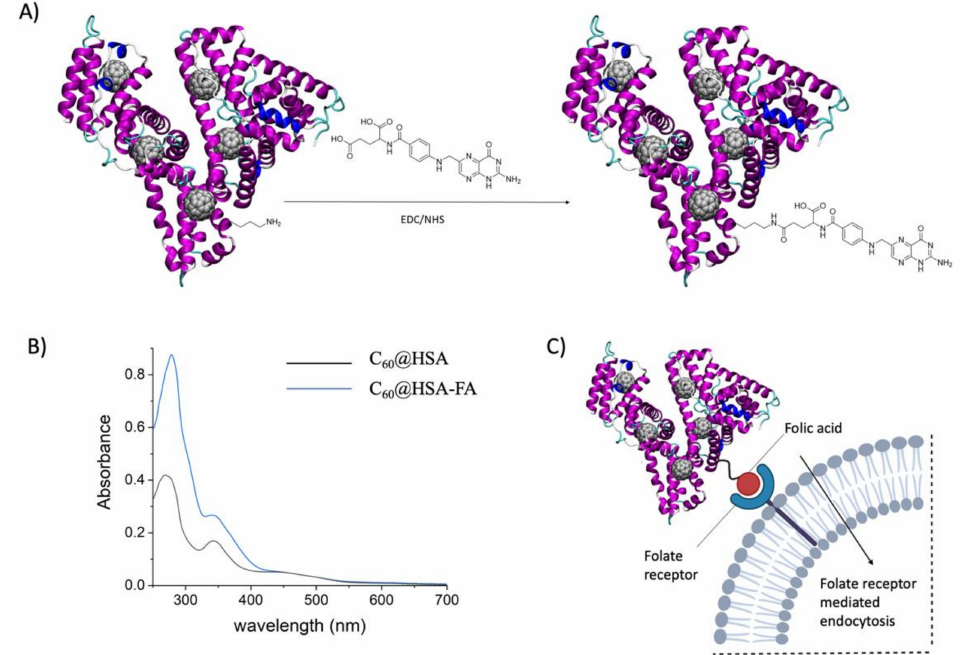
Figure 3. ( A ) Bioconjugation of folic acid to C 60 @HSA. ( B ) UV–visible spectra of C 60 @HSA (black line) and C 60 @HS-FA (blue line) in PBS. In Figure S9, the UV–visible spectrum of FA in PBS. ( C ) Folate- receptor-mediated